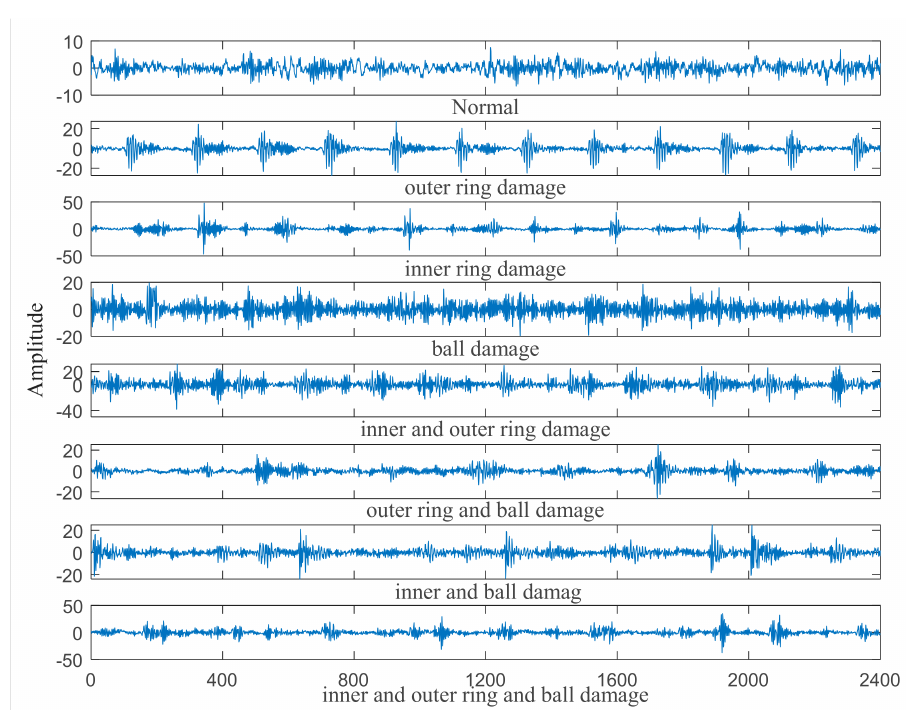
Figure 12. The time-domain signal for di ff erent fault